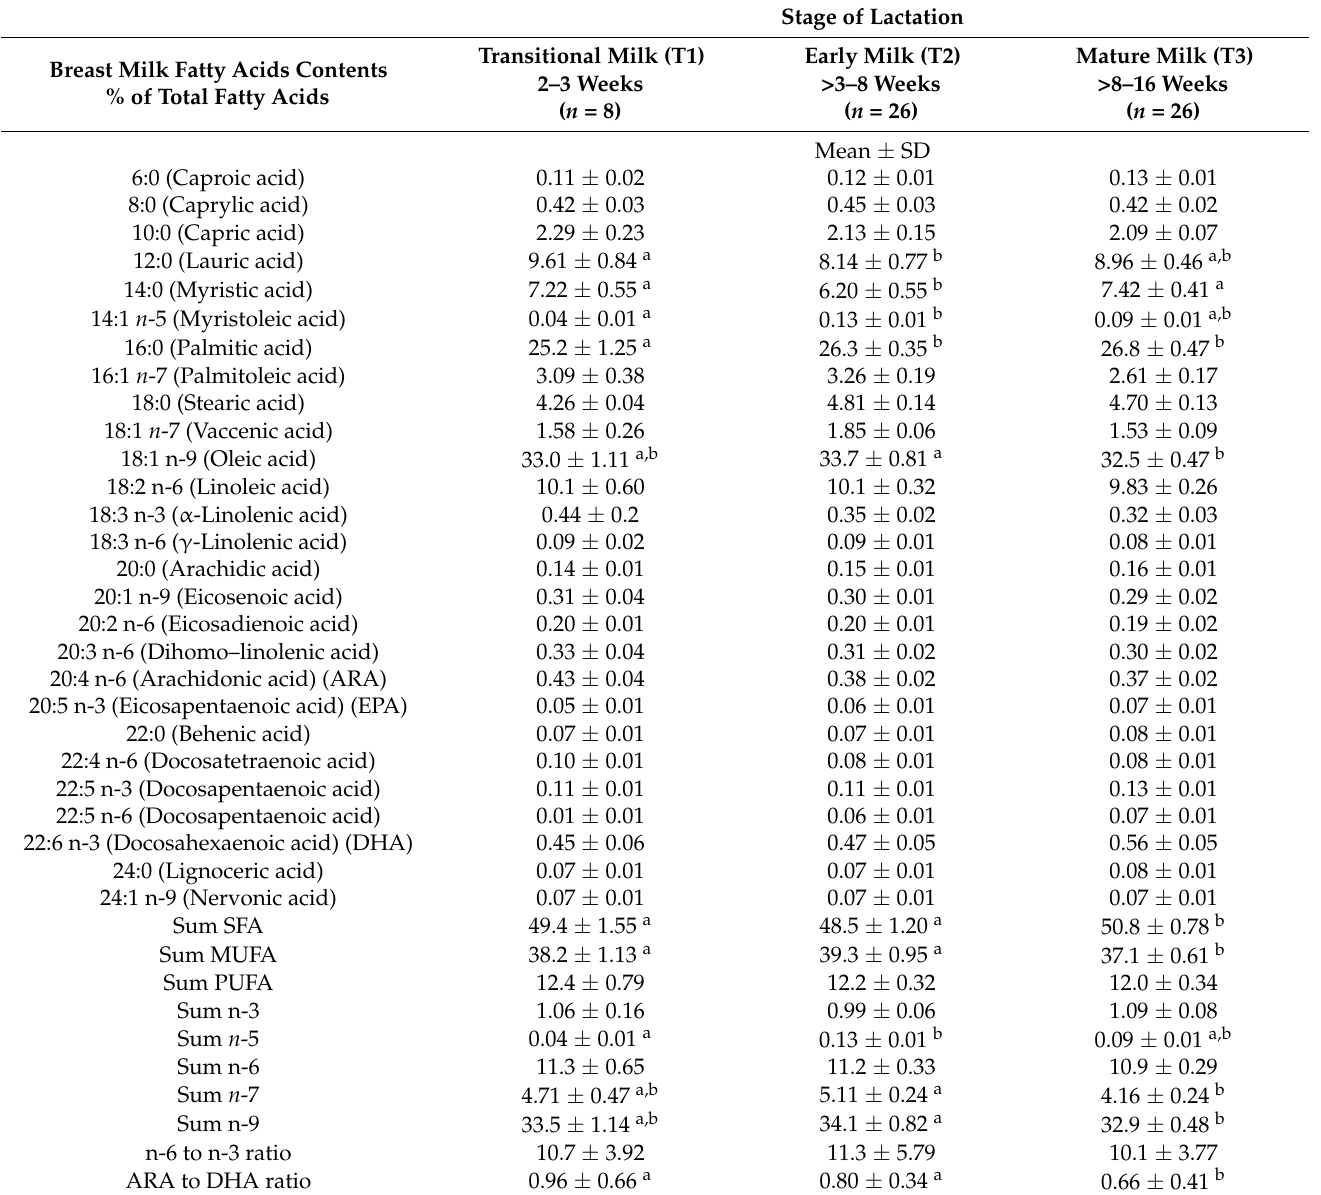
Table 1. Breast milk fatty acids concentrations according to the stage of lactation (T1, T2 & T3).